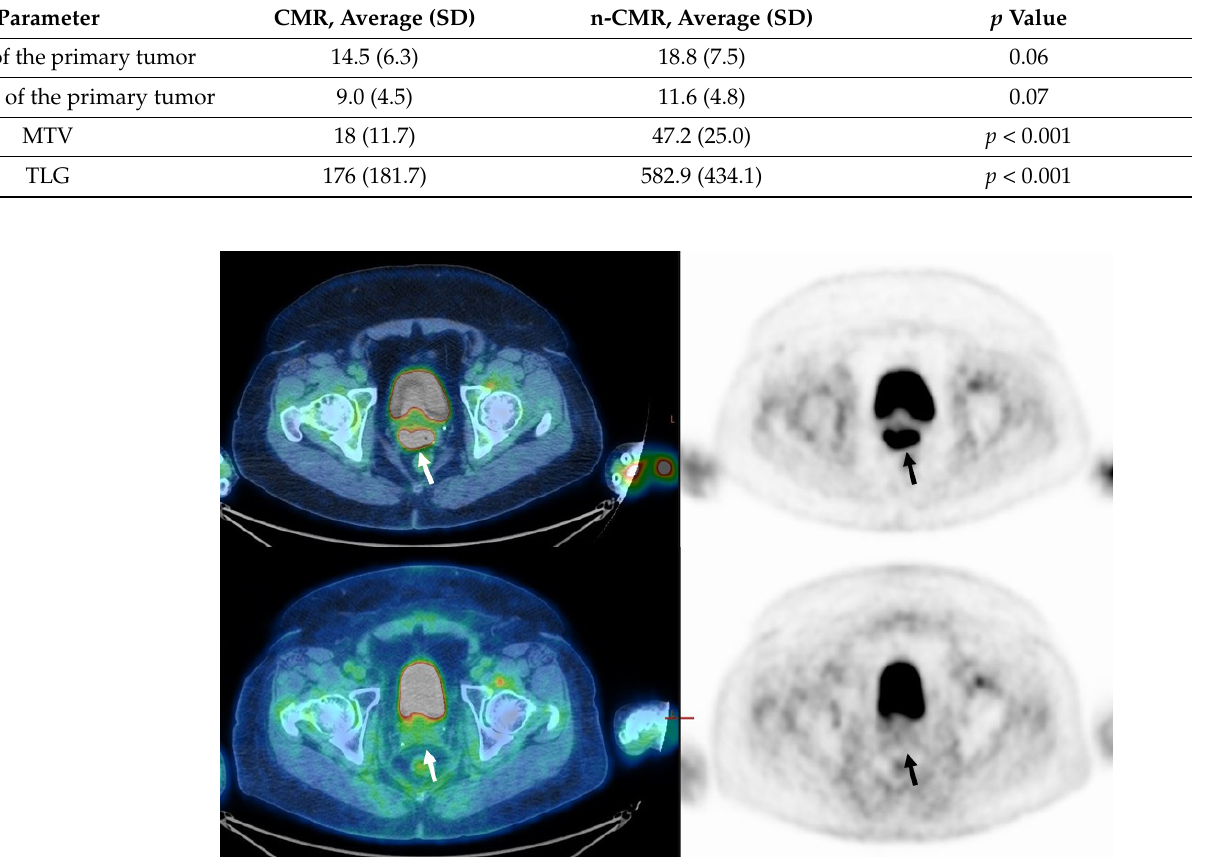
Figure 1. Sixty-two-year-old woman with FIGO stage IIB cervical cancer (Squamous cell carcinoma). On staging, PET/CT images (upper row) demonstrate uptake in the primary tumor only (arrow). MTV was 6.9 cm 3 and TLG was 65.5. On PET/CT performed about 3 months after the end of treatment (lower row), no pathological uptake is seen (CMR, arrow).